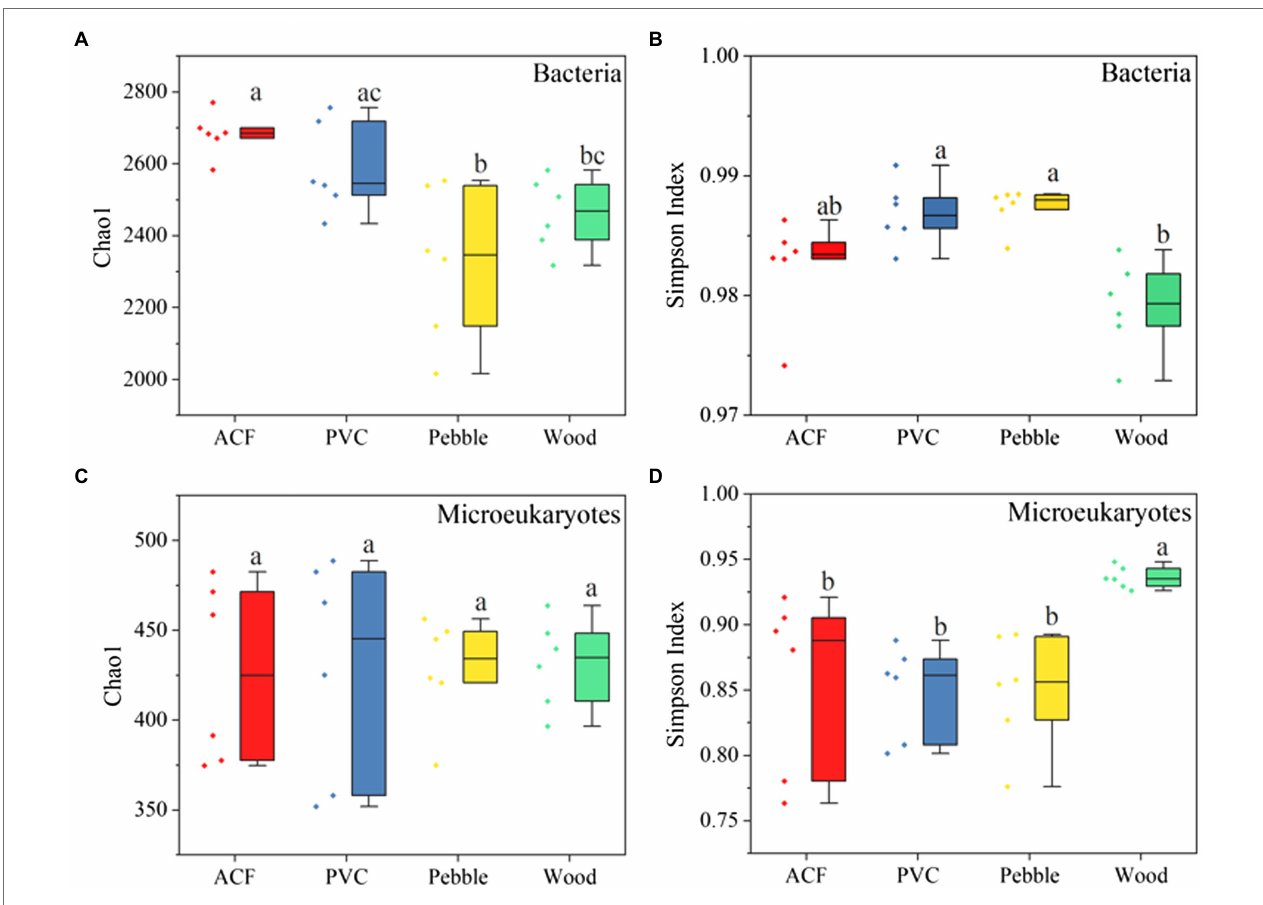
FIGURE 1 | Alpha diversity of bacteria including Chao1 (A) and Simpson (B) indices and microeukaryotes composed of Chao1 (C) and Simpson (D) indices, for artificial [artificial carbon fibre (ACF) and polyvinyl chloride (PVC)] and natural (pebble and wood) substrates. The letters represent a significant difference at value of